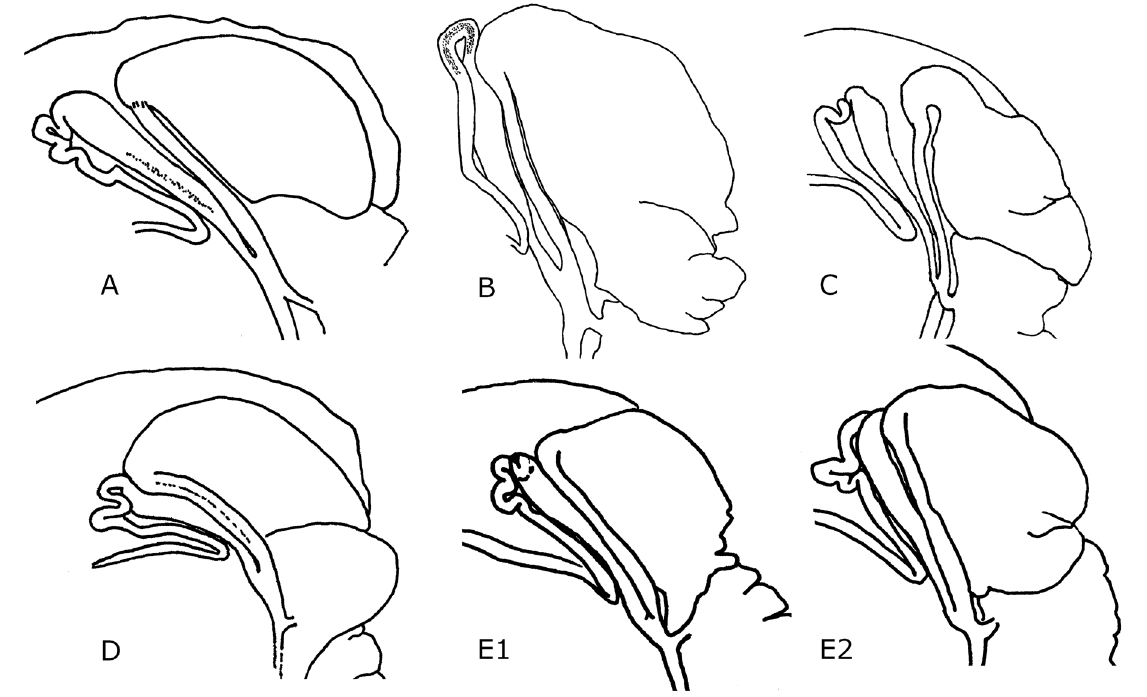
Fig. 23. Variation of the female genitalia in Cochlostoma ( Clesssiniella ) anomphale Boeckel, 1939. A . Eisenkappel, Austria (EZ0034). B . Savinjska Dolina, Slovenia (WdM1579). C . Vellach, Austria (EZ0991). D . Logarska Dolina, Slovenia (EZ0994). E1–E2 . Solčava, Slovenia